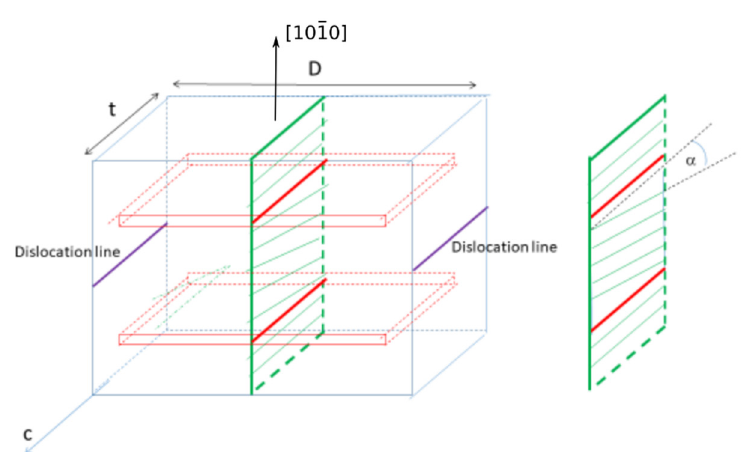
Figure 5. Schematic drawing indicating the angular deviation of the Bragg diffracting planes (schematised by green lines) in the region lying between the dislocations (violet lines) with opposite Burgers vectors. This region is misoriented by an average angle α with respect to the matrix. The direction of the diffraction vector h is indicated. On the right side of the figure we show the approximation we use for the discussion, where we consider an angle α constant over the volume lying between the subgrain boundary-like regions, represented by the rectangular volumes in